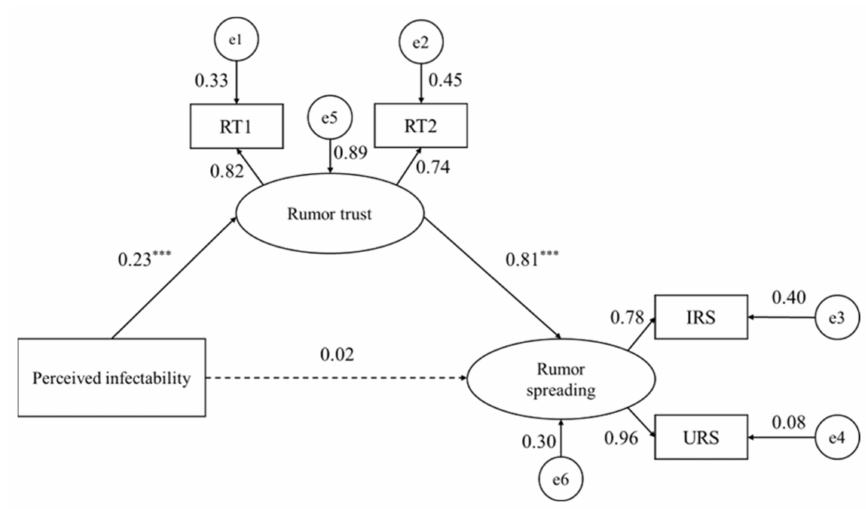
Figure 1. Standardized path coefficients for the mediation model. RT = Rumor trust, IRS = Intentional rumor spreading, URS = Unintentional rumor spreading. *** p < 0.001. Table 2. Mediating effect analysis in Study